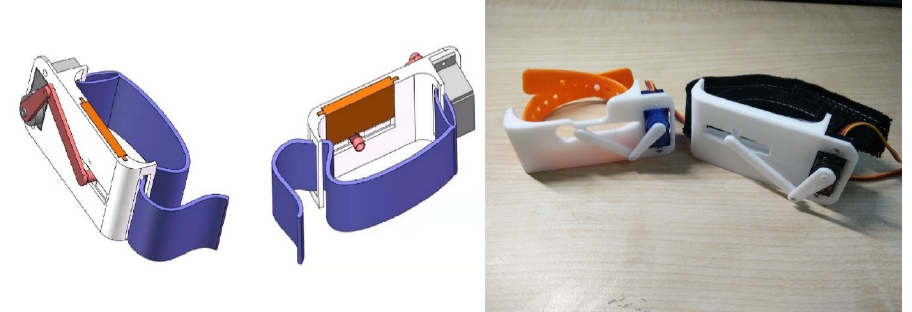
Figure 8. Proof-of-concept prototype of guidance wristband.